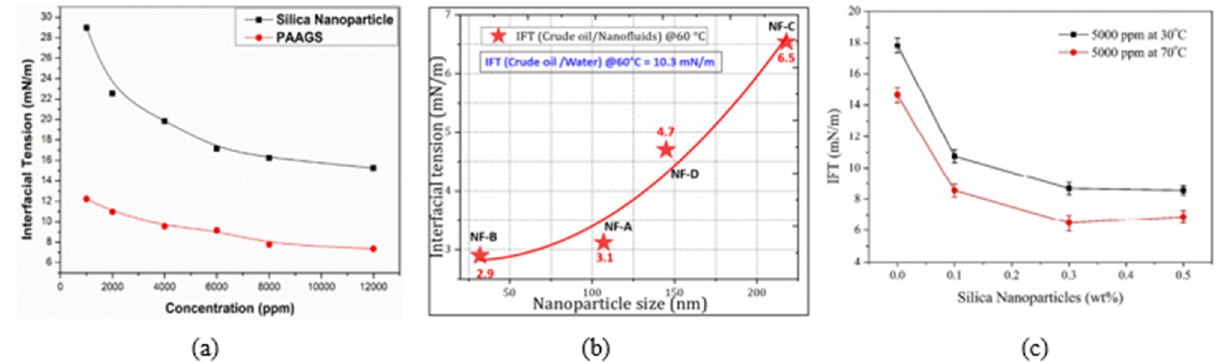
Figure 6: ( a ) IFT values of SNP and synthesized PAAGS. ( b ) Variation in the IFT measured with Spinning drop technique ( at 60°C ) with NP size. ( c ) E ff ect of SNPs concentration and temperature on the IFT of crude oil - polymer - SNPs solution system at 5,000 ppm xanthan gum [ 172 ]